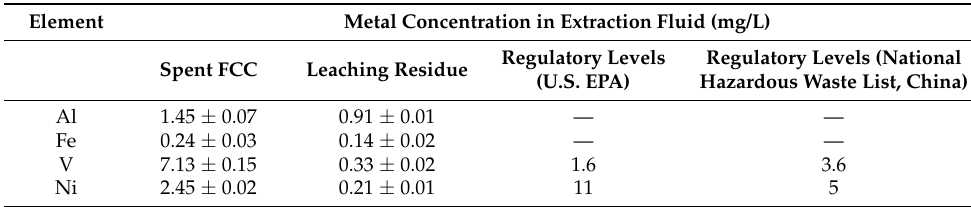
Table 3. TCLP test results for the spent FCC catalyst and leaching residue. Element